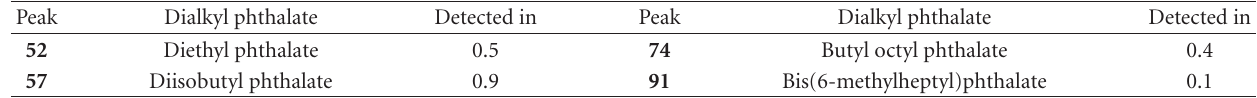
Table 5: Dialkyl phthalates detected in the products from ASF ODVR .